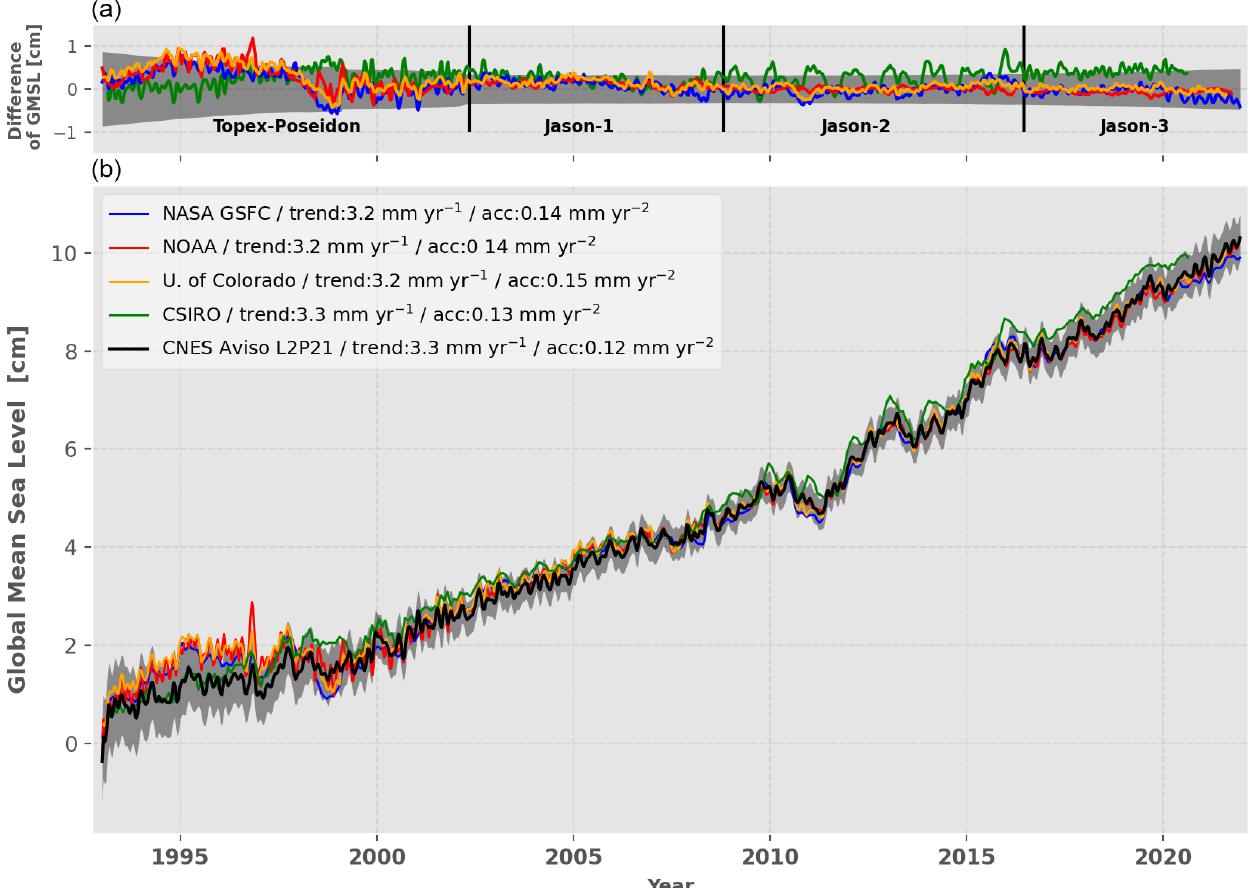
Figure 5. (b) Comparison of the CNES/AVISO+ L2P21 GMSL record with other solutions: NASA GSFC v5.1, NOAA STAR, University of Colorado, CSIRO. All the records have been corrected for TP-A drift as well as for the GIA. Seasonal signals are removed, and the time series are 2-month-filtered. The uncertainty envelope of the CNES/AVISO+ L2P21 GMSL (shaded grey area) is given at the 90%C.L. (1 . 65 σ ). (a) Difference between the L2P21 GMSL record and the other respective solutions. Vertical dashed lines indicate the dates of switch between altimetry